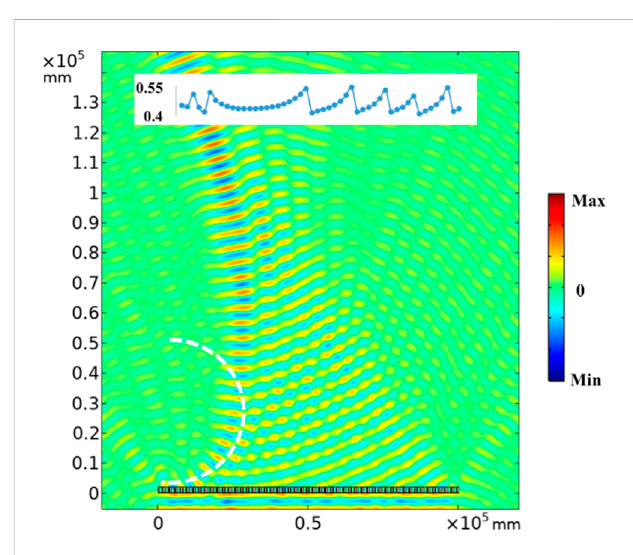
FIGURE 3 Normalized self-bending beam pressure distribution under an upward incident wave. The design target is the white half circle with a radius equal to 5 λ . The inset shows the r values of the designed